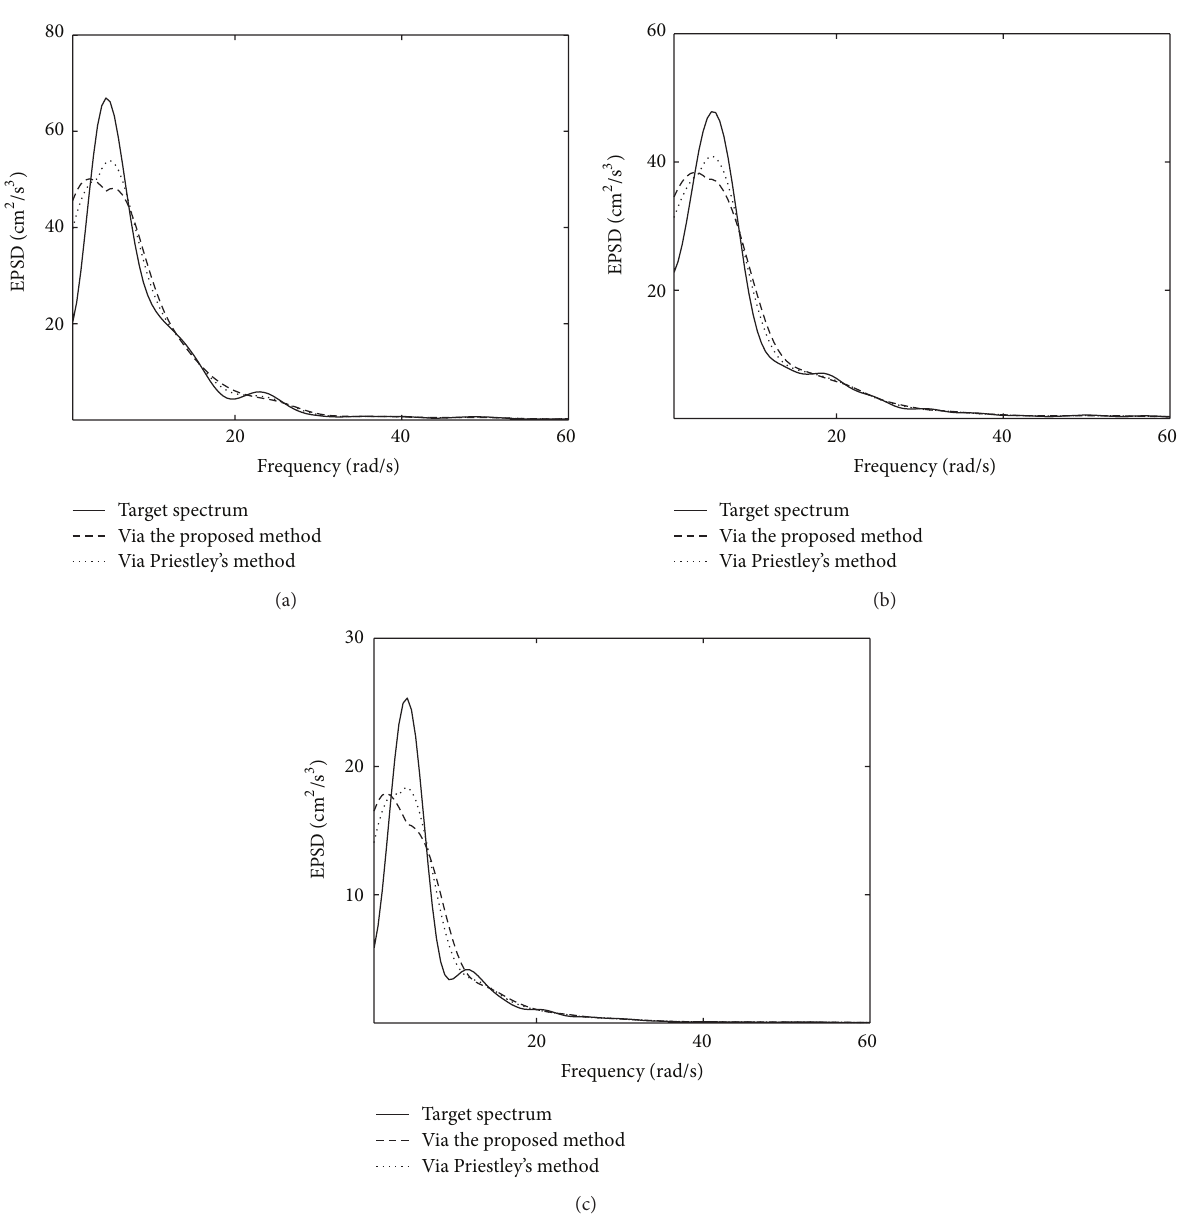
Figure 7: Comparison between the bias errors of the proposed method 𝑆 12 (𝜔,𝑡) and Priestley’s method 𝑆𝑃 12 (𝜔,𝑡) : (a) at time instant t = 2s; (b) at time instant t = 4 s; (c) at time instant t = 12